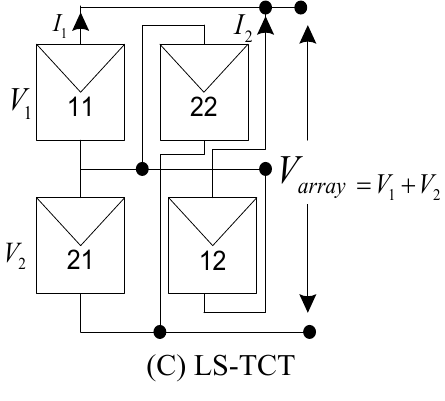
Figure 4. Schematic diagram of PV array configuration